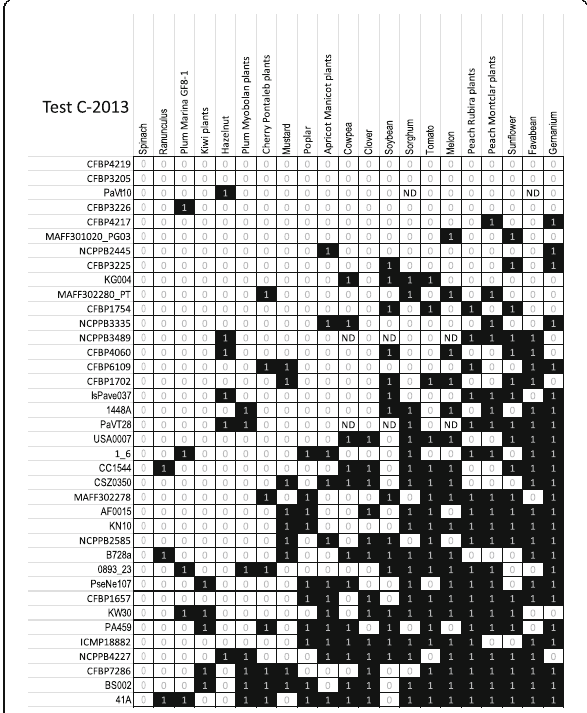
Fig. 3 Host range of strains evaluated in test C. Black boxes correspond to plant-strain interactions where at least 3 of the 4 inoculated replicate herbaceous plants had disease scores > 1 and at least 3 of the 4 inoculated woody plants had external lesions longer than 0.1 cm. Strains are arranged in terms of increasing number of hosts and plant species are arranged in terms of increasing number of virulent strains. ND indicates missing